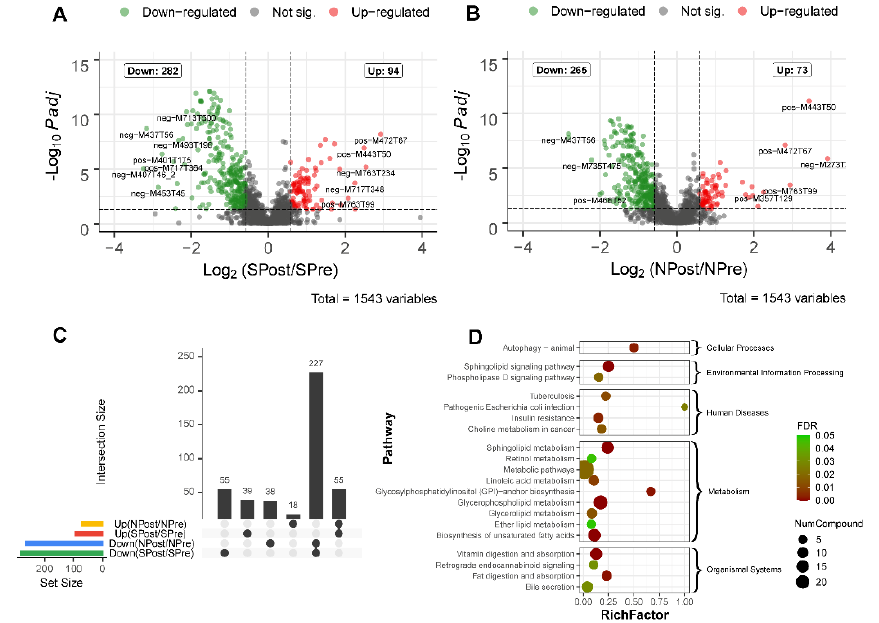
Figure 3. Differential lipids for sepsis patients ( n = 30) before and after surgery. Volcano plot of sepsis ( n = 30) ( A ) and nonsepsis patients ( n = 30) ( B ). The x-axis is the mean ratio fold-change (plot- ted with a log 2 scale) of the relative abundance of each feature between the patients after and before surgery. The y-axis represents the adjusted p value (FDR) of the ratio fold-change for each feature. An UpSet diagram shows differentially expressed identifications that are unique or shared among four comparison groups ( C ). Pathway enrichment analysis of differentially expressed lipids is pre- sented in the bubble chart ( D ). The y-axis corresponds to KEGG pathway items, and the x-axis rep- resents the enrichment factor. The color of the dot represents FDR, and a lower FDR indicates more significant enrichment. The point size represents the number of differentially expressed lipids that are mapped to the reference pathways. The rich factor refers to the level of enrichment, which is the ratio of the differentially expressed lipids annotated in this pathway to all lipids annotated in this pathway item. A greater enrichment factor indicates a more significant enrichment. 3.5. Signature Discovery and Evaluation Related to Sepsis We used our lipid datasets to perform the discovery and evaluation of potential sig- nature molecules related to sepsis. By comparing sepsis and nonsepsis samples after sur- gery with the Wilcoxon test, we found very few significantly differential lipids. Therefore, we inferred that in a clinical lipidomic dataset with surgical intervention effects, solely